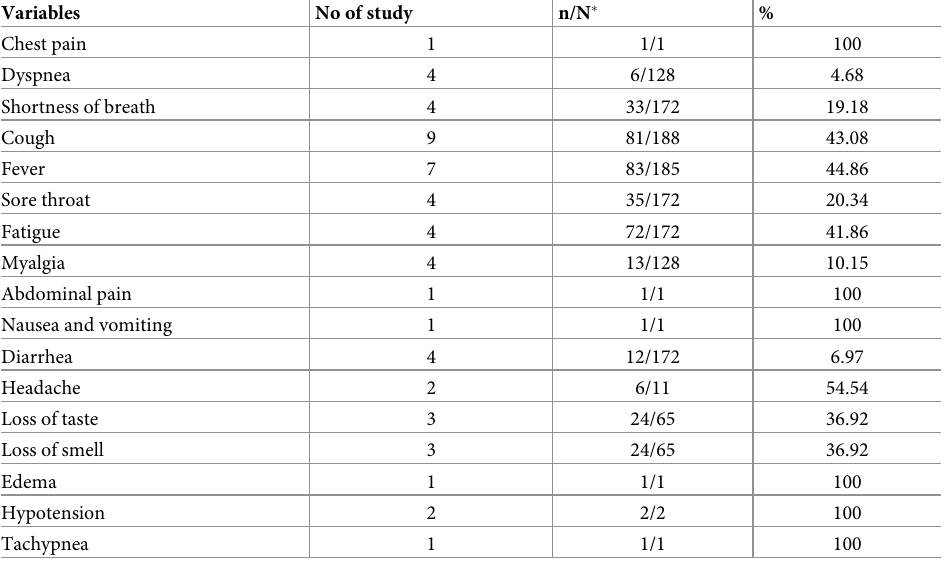
� n: number of patients with any variable, N: Total number of mothers with COVID-19.